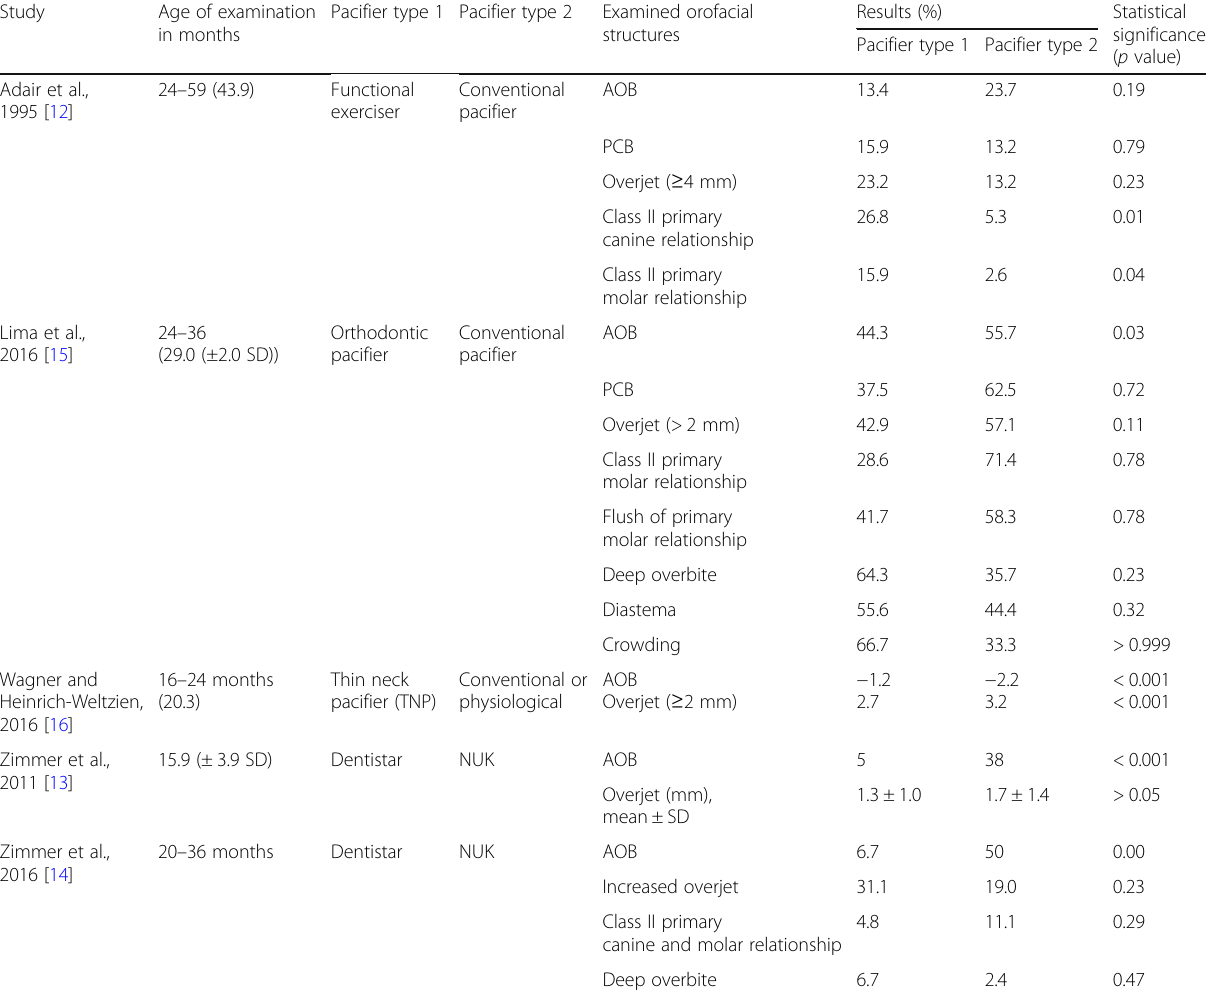
Table 3 Effects of different types of pacifiers on orofacial structures Study Age of examination in